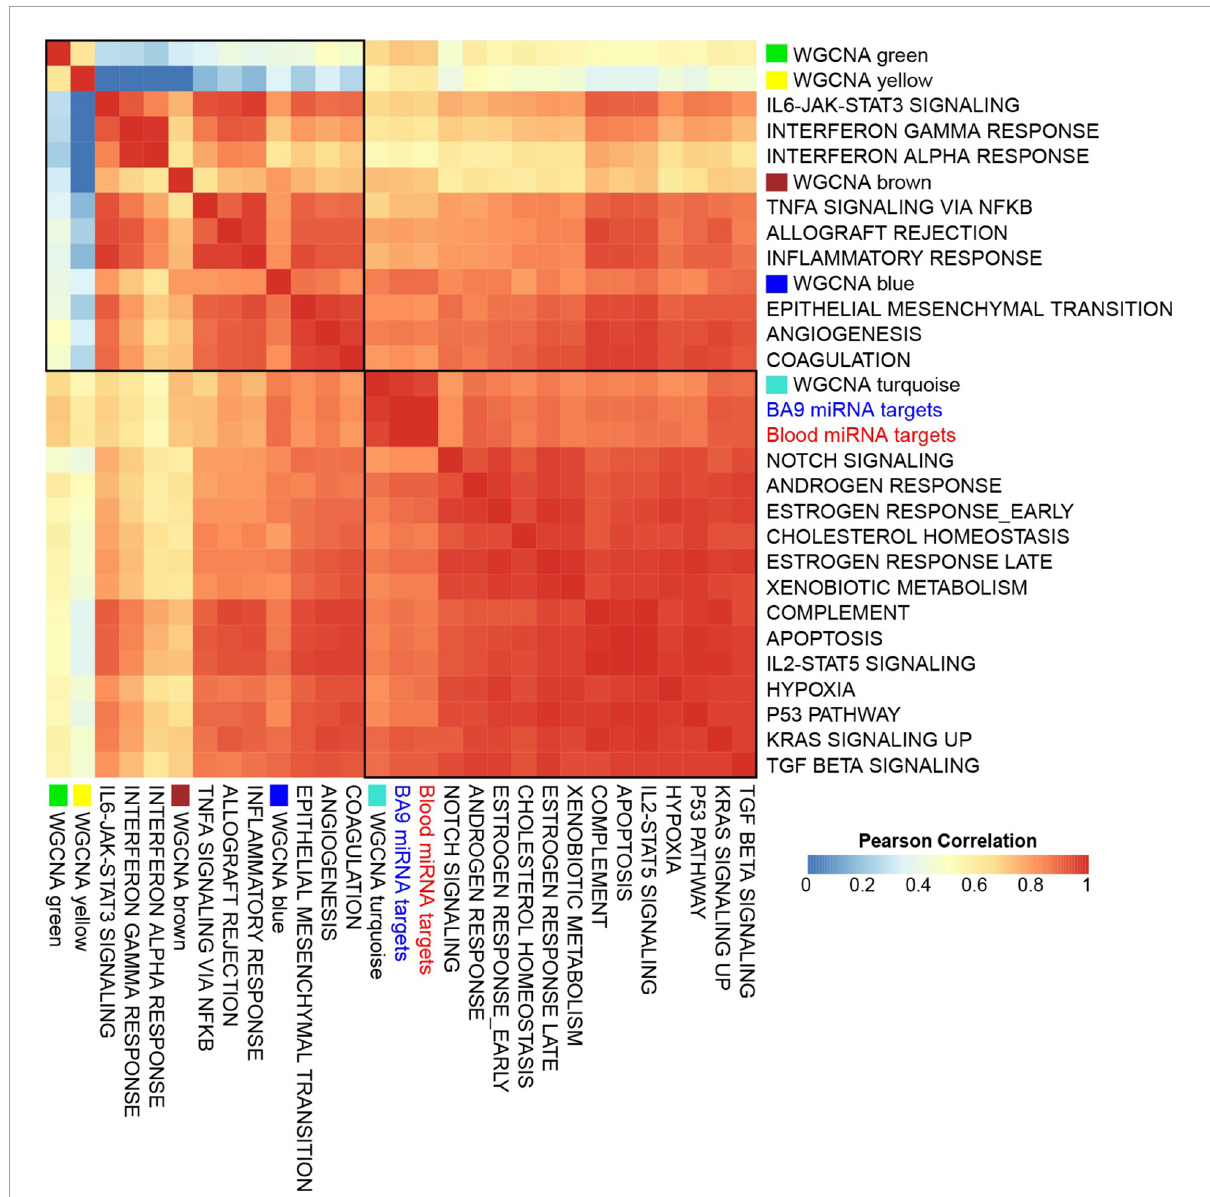
FIGURE6 Gene set signatures for miRNA targets show robust and distinct correlation patterns. Gene signature scores were derived for opioid use disorder (OUD) down-regulated BA9 and blood miRNA targets, as well as for WGCNA modules, and comprehensive correlations were computed with the 50 Hallmark pathways over a collection of BA9 bulk tissue transcriptomes from 425 control brain samples from the GTEx project. Presented here is a subset of the Hallmark pathways, showing that OUD down-regulated targets of BA9 and blood miRNAs and the WGCNA turquoise module correlated with Hallmark pathways for Notch signaling, apoptosis, hypoxia, and TGFß signaling; WGCNA modules brown and blue correlated with immune system, inflammatory pathways, angiogenesis, and